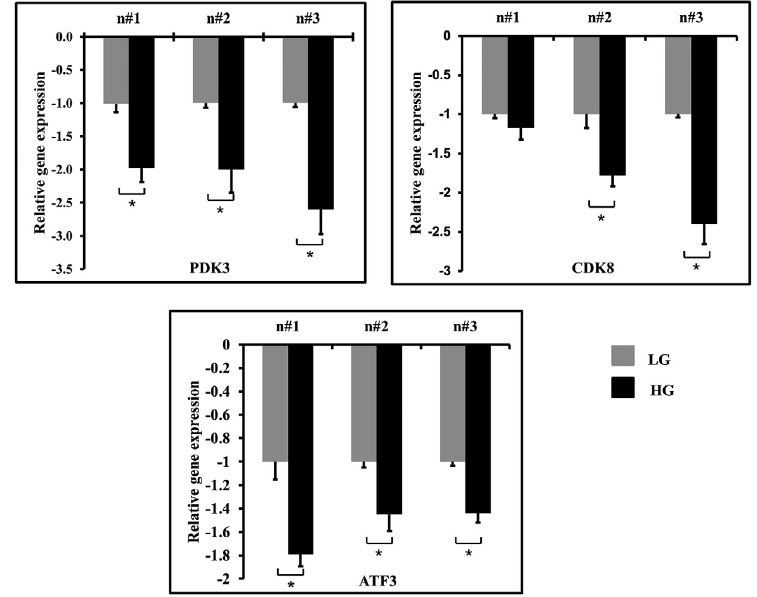
Figure 5- RT-qPCR validation of selected genes on day 1. The mRNA expression was validated from dental pulp cells obtained from 3 individuals: n#1 (donor number 1), n#2 (donor number 2), n#3 (donor number 3). Low glucose (LG) and High glucose (HG). * indicates a statistically significant difference between groups (p<